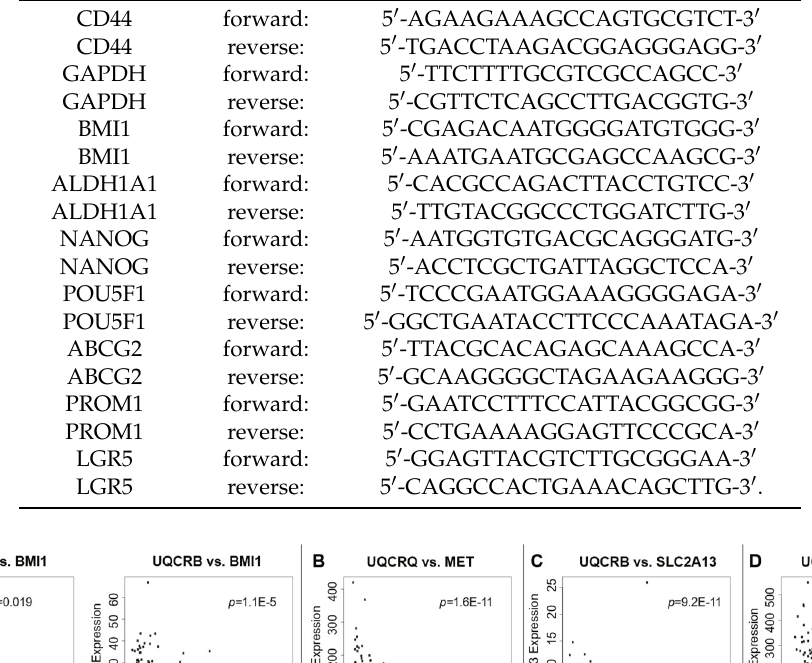
Table 1. Primer sequences used for quantitative PCR.